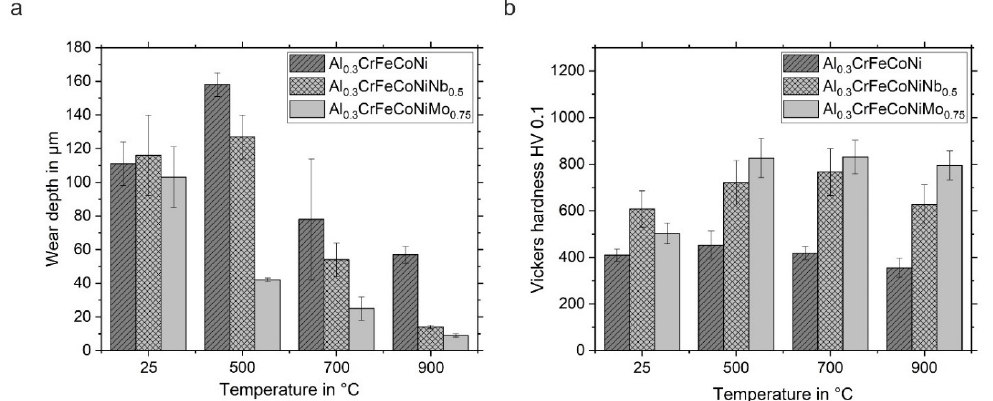
Figure 5. Results after high-temperature wear test: ( a ) Wear depth of the HVOF-sprayed coatings of Al 0.3 CrFeCoNi, Al 0.3 CrFeCoNiNb 0.5 , and Al 0.3 CrFeCoNiMo 0.75 at different temperatures, and ( b ) Vickers hardness HV 0.1 of these coatings after high-temperature wear tests at different